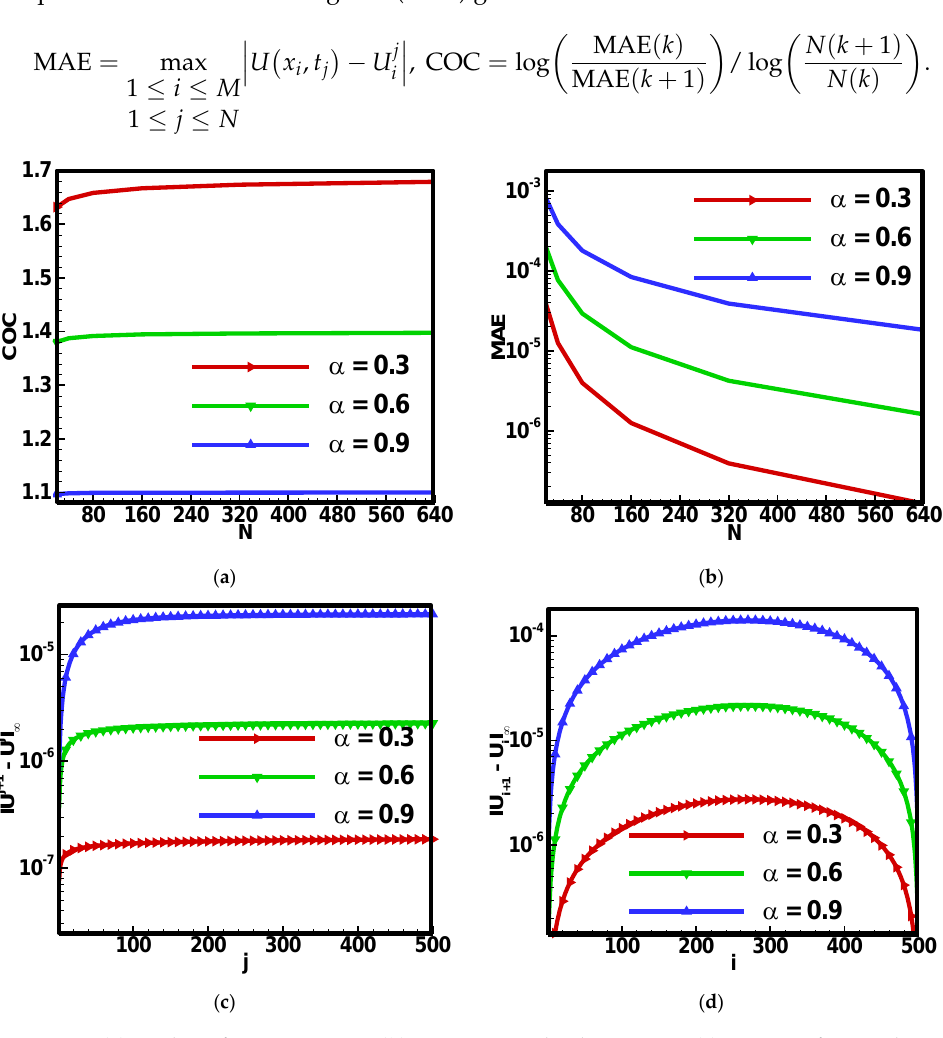
Figure 2. ( a ) Order of convergence; ( b ) Maximum absolute error; ( c ) L-norm for mesh size j ; ( d ) L-norm for mesh size i .